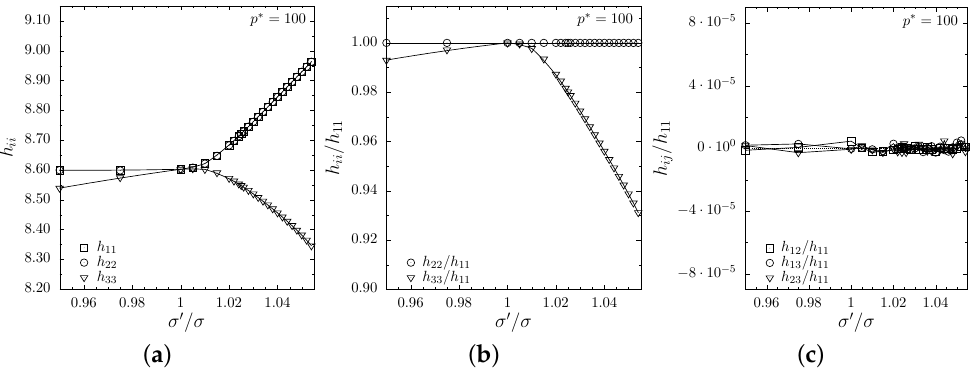
Figure 3. The ( a , b ) diagonal and ( c ) off-diagonal box matrix elements. In ( b , c ) plot the respective h ii and h ij elements have been divided by h 11 values, to show that the shape of the box corresponds to the tetragonal symmetry. The lines are drawn to guide the